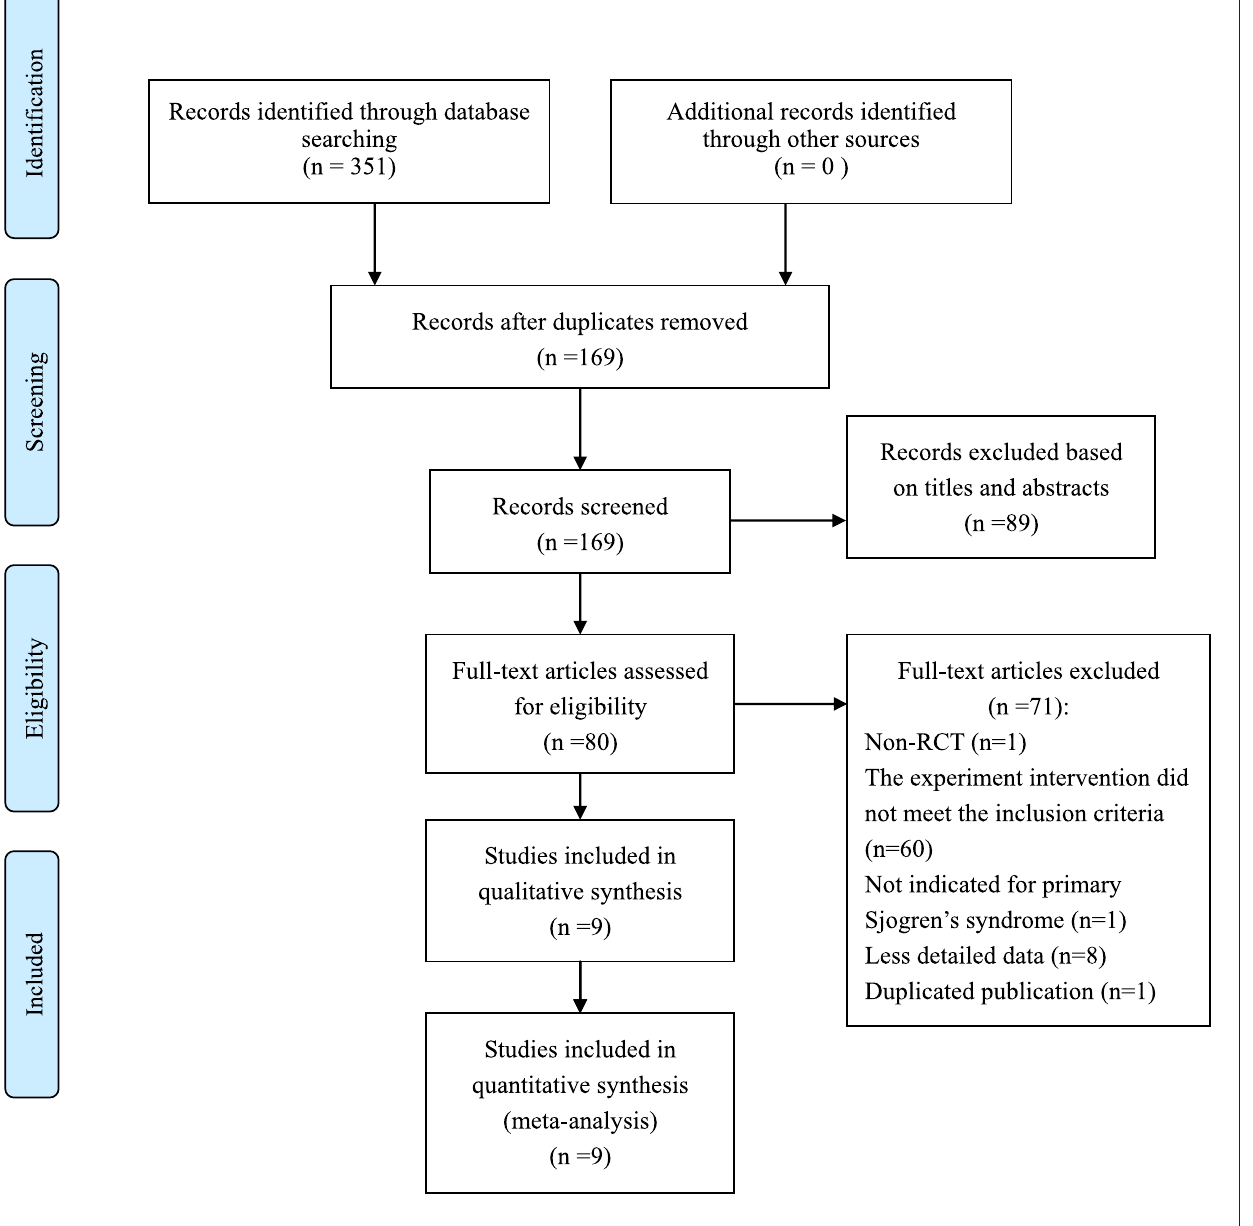
FIGURE 1 | Flow chart of trials